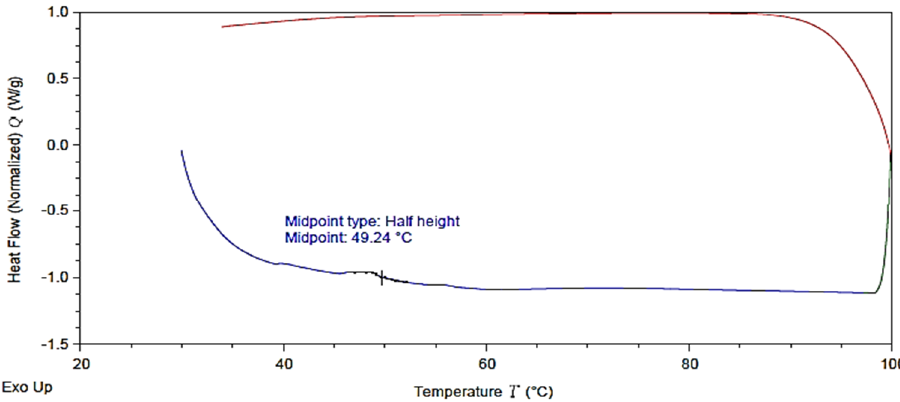
Figure 12. DSC analysis for the optimal printed sample.